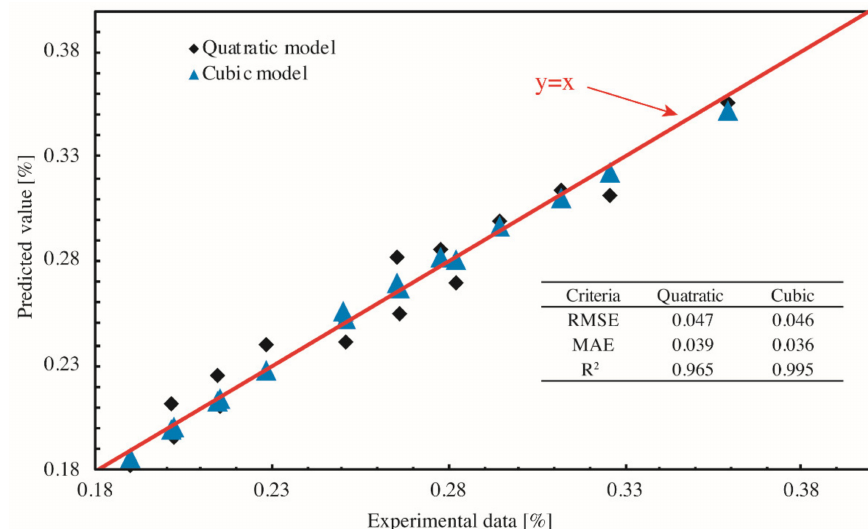
Figure 15. Performance of prediction.